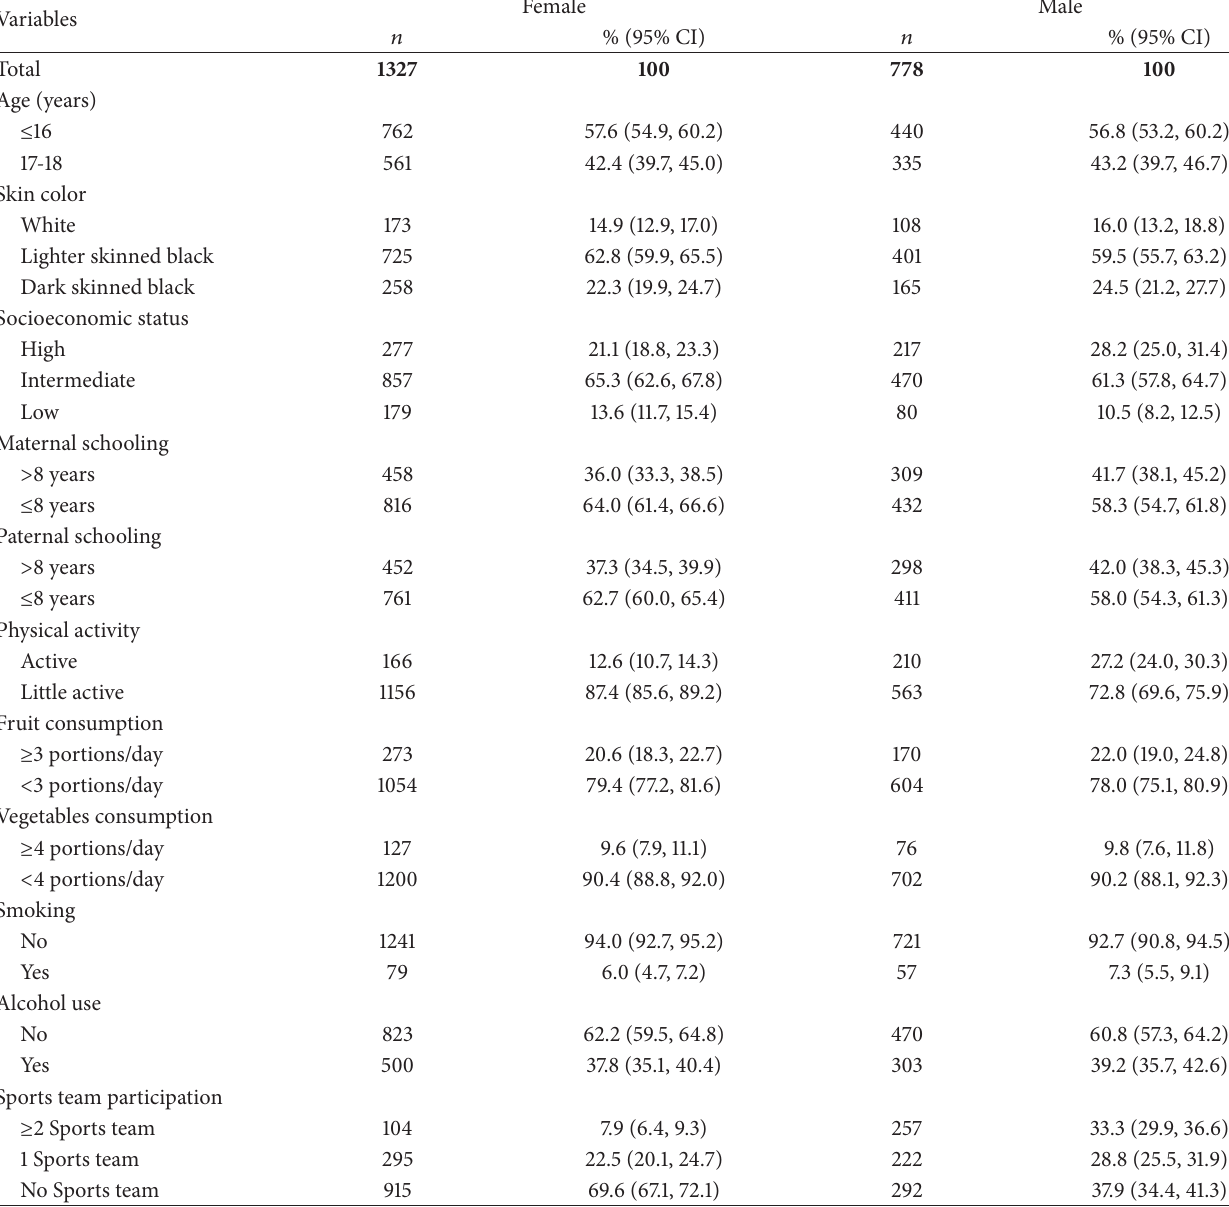
Table 1: Sample distribution and descriptive characteristics according to